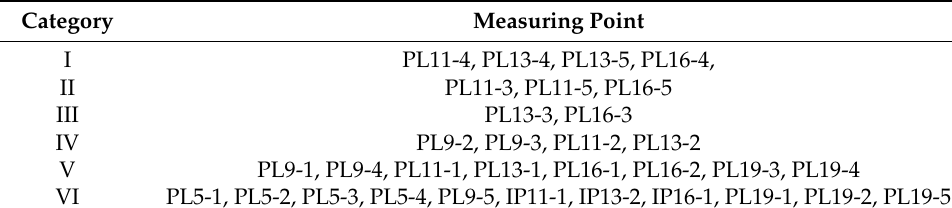
Table 3. Zoning results of deformation measuring points of the ultra-high arch dam during the third phase.